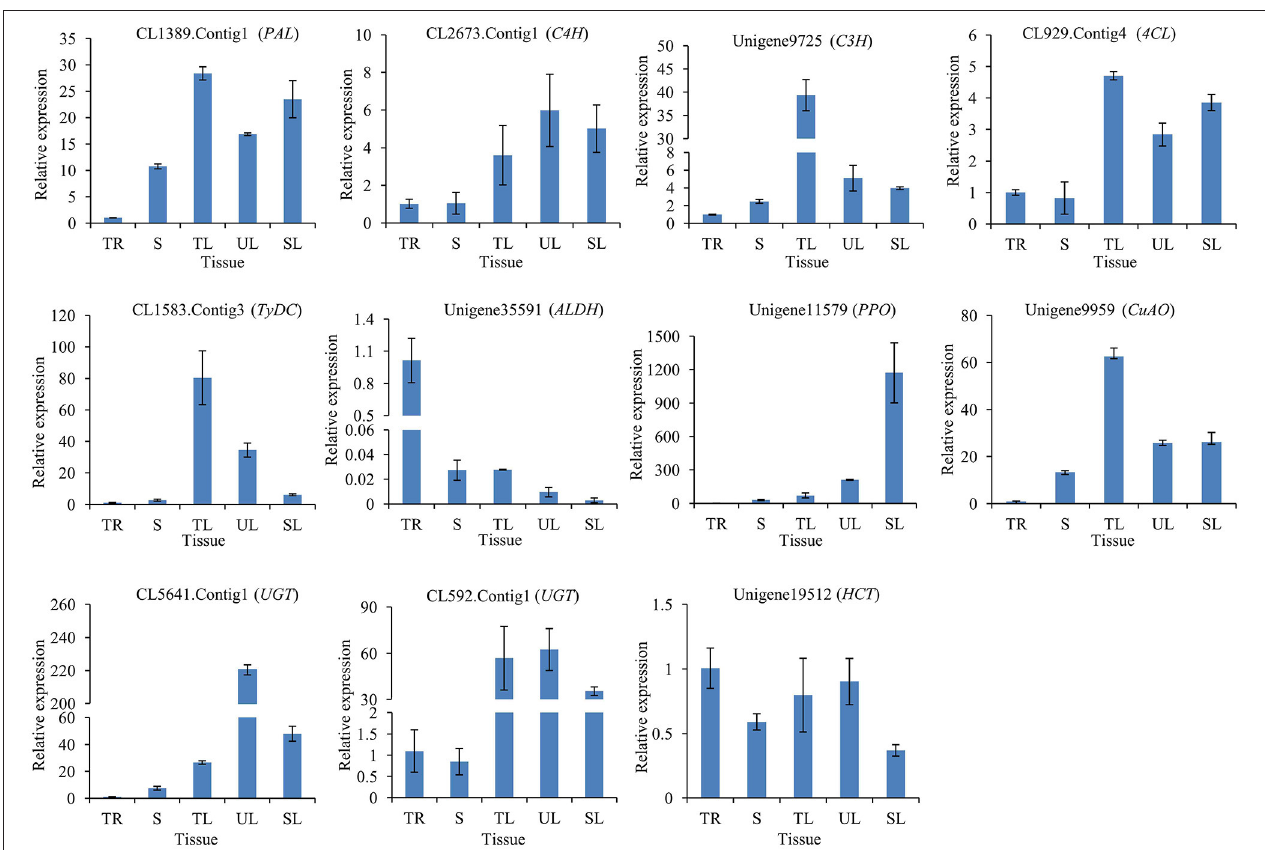
FIGURE 7 | Expression of candidate genes involved in biosynthesis of acteoside across five tissues of R. glutinosa . These genes expression level were all determined by Real-time PCR. Vertical bars indicate the standard deviation of three biological replicates. TR, Tuberous root; S, Stem; TL, Tender leaf; UL, Unfolded leaf; SL, Senescing